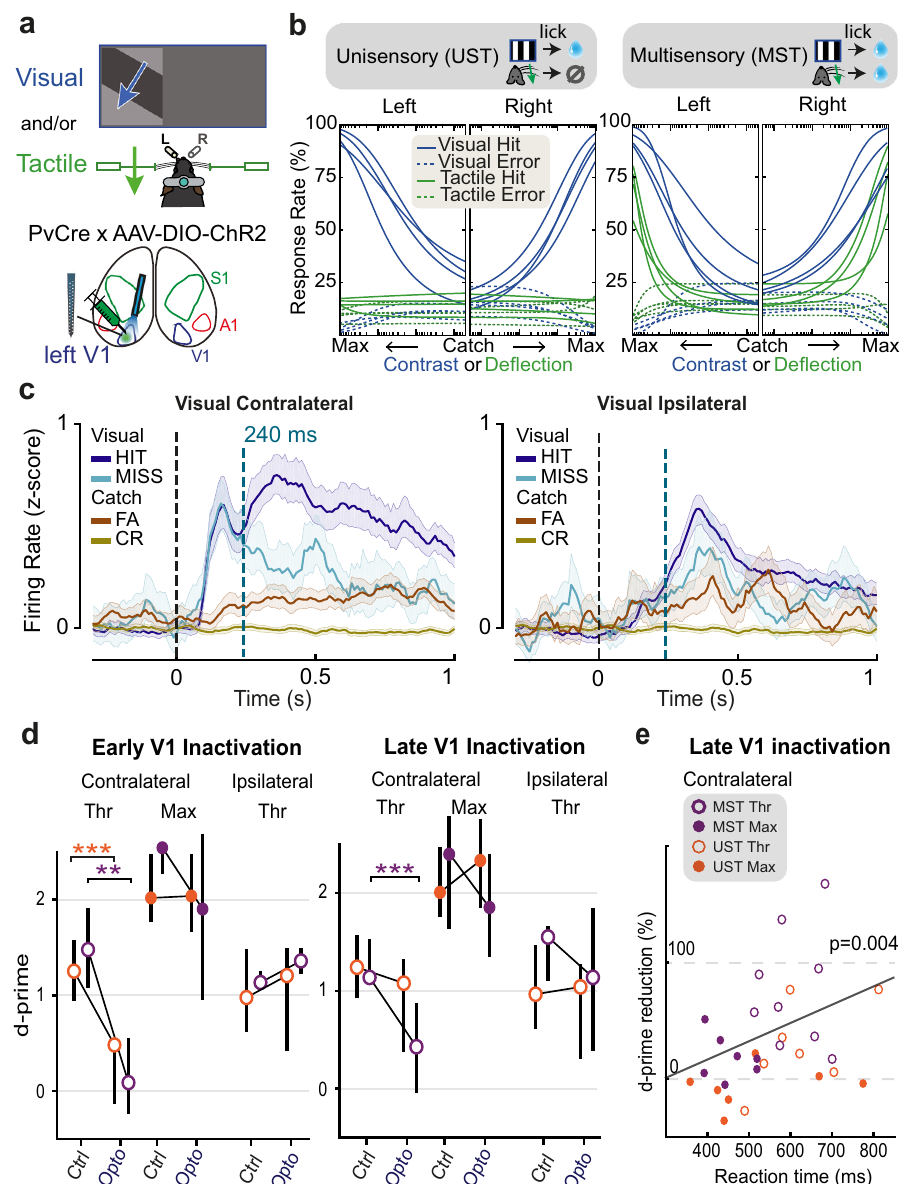
Fig. 6 Extended causal requirement of V1 generalizes to visuotactile side detection. a Schematic of the visuotactile two-sided detection task in which mice reported the side of visual and/or tactile stimulation. b Psychometric fi ts for visual and tactile detection for each mouse trained in the UST and MST version of the task. Same conventions as in Fig. 1c – e, with the x-axis running left for visual/tactile stimuli presented to the left side and right for visual/ tactile stimuli presented to the right side. Visual and tactile intensities were normalized for rendering purposes. c Average z-scored fi ring rate of responsive V1 neurons during visual (max contrast) and catch trials, split by trial outcome. Only neurons from MST mice are shown. The dashed blue line indicates the onset of optogenetic silencing. Similar to Task A, contralateral hits elicit more late activity compared to misses. Also note the weak early transient activity during FA trials (analogously to Task A, see Fig. 2e). Shaded area: bootstrapped 95% con fi dence intervals. d Visual d-prime across V1 inactivation conditions. Early V1 inactivation (left) impaired the detection performance of contralateral threshold-level visual stimuli in both UST (ANOVA, n = 7 sessions, F (1,14) = 24.57, p = 0.0006318) and MST (ANOVA, n = 6, F (1,12) = 17.93, p = 0.0023), without effect on ipsilateral threshold-level stimuli nor contralateral maximum-level stimuli. Late silencing (right) only affected detection performance of contralateral threshold stimuli in MST mice (ANOVA, n = 7 sessions, F (1,14) = 45.14, p = 0.000036), but not in UST mice (ANOVA, n = 7, F (1,14) = 2.15, p = 0.164). ** p < 0.01, *** p < 0.001. Each corrected for four multiple comparisons (Bonferroni-Holm). Errorbars denote inter-quartile range. e Reduction in d-prime by late silencing correlated with the median reaction time on corresponding control trials (ANOVA, n = 30 conditions, F (1,26) = 9.785, p = 0.00427, r 2 = 0.7056). Each dot represents a